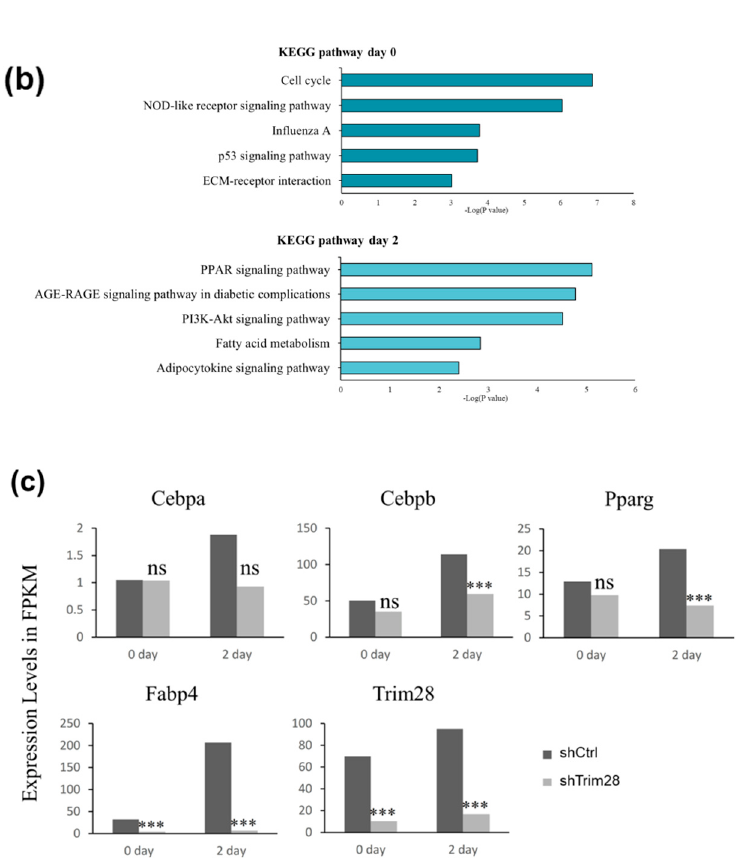
Figure 2. RNA-seq analysis in Trim28 KD 3T3-L1 cells. Genes were characterized as gene ontology (GO) biological processes ( a ) and Kyoto encyclopedia of genes and genomes (KEGG) pathway ( b ) in Trim28 knockdown (KD) vs. control cells at day 0 and day 2. ( c ) The expression level in FPKM (fragments per kilobase of transcript per million) of master regulators of adipocyte differentiation in Trim28 KD vs. control cells at day 0 and day 2 were shown. *** p < 0.001, ns: not significant.